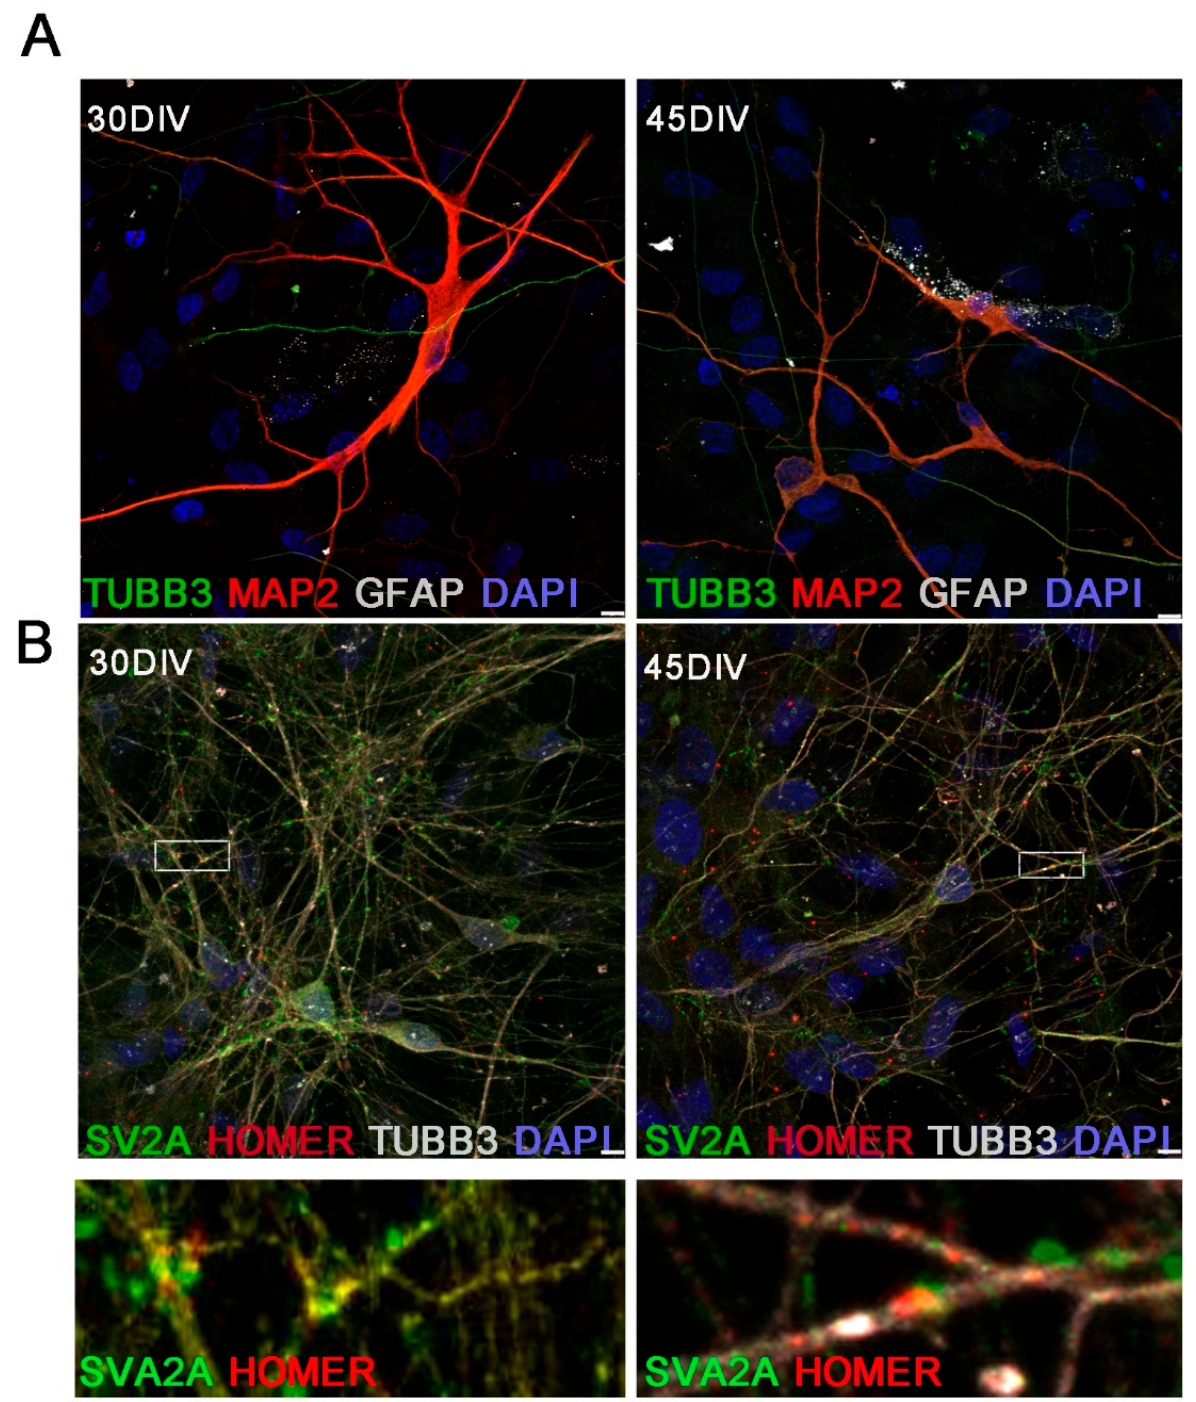
Figure 5. Expression of neuronal proteins in hiPSC-derived neurons. ( A ) Representative confocal images of hiPSC-derived neurons at 30–45 DIV showing expression of the neuronal markers TUBB3 and MAP2 and the astrocyte marker Glial Fibrillary Acidic Protein (GFAP). Scale bar 7.5 µm. ( B ) Synaptic proteins SV2A (green) and HOMER (red) co-localized at 30–45 DIV. Scale bar 7.5 µm. The rectangle frames are the regions of interest shown below at higher magnification.